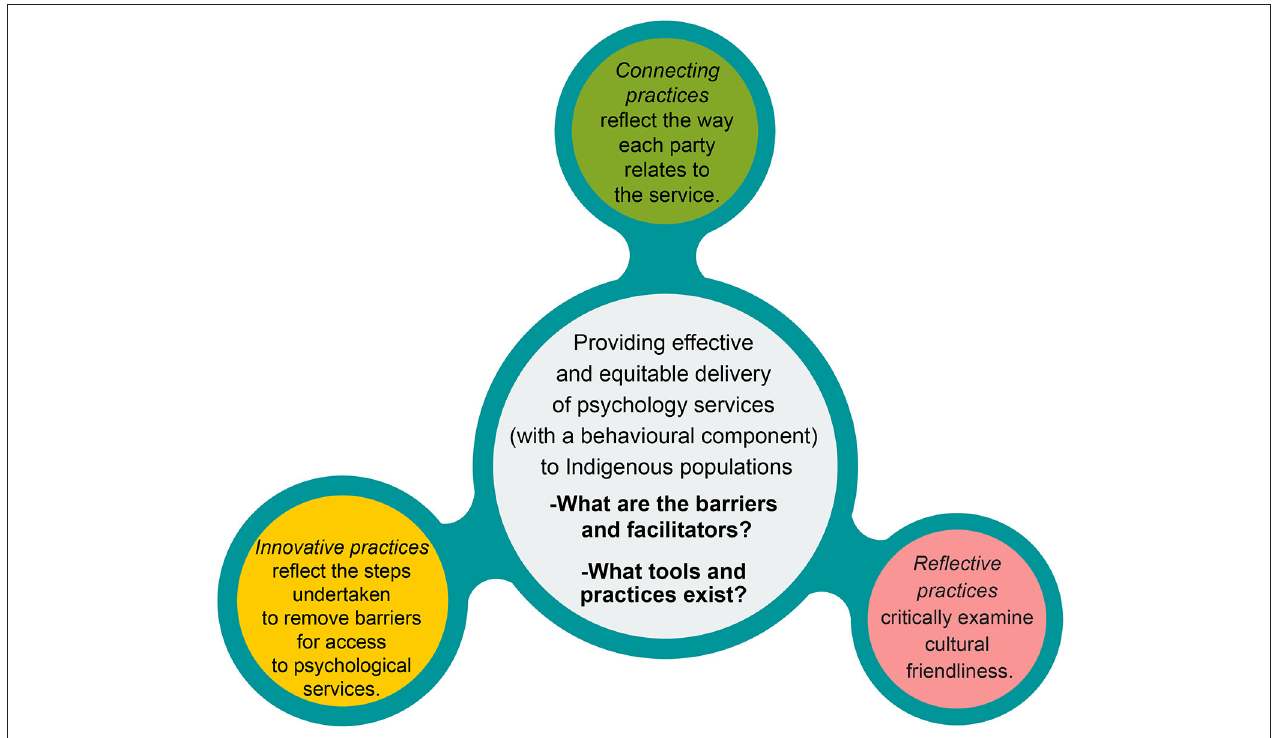
FIGURE 3 | A schematic representation of the developed thematic